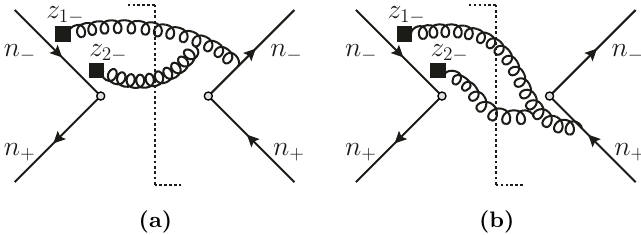
Figure 3. Diagrams contributing to the S 4 soft function. Same conventions as in figure 1 are used. The filled squares stand for the soft covariant derivative and the Wilson lines contained in B + µ ⊥ ( z 1 − ) B + ( z 2 − ) . µ ⊥